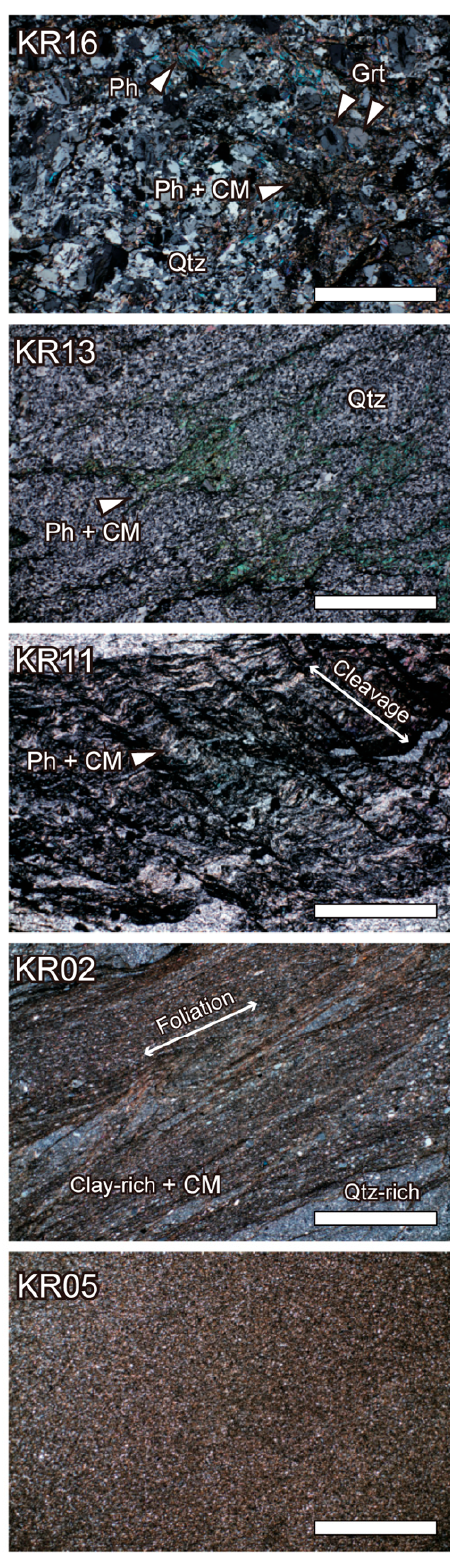
Figure 3. Examples of Raman spectra and photomicrographs of the pelitic rock samples. CM: carbonaceous material; Grt: garnet; Ph: phengite; Qtz: quartz. Scale bars are 2 mm.